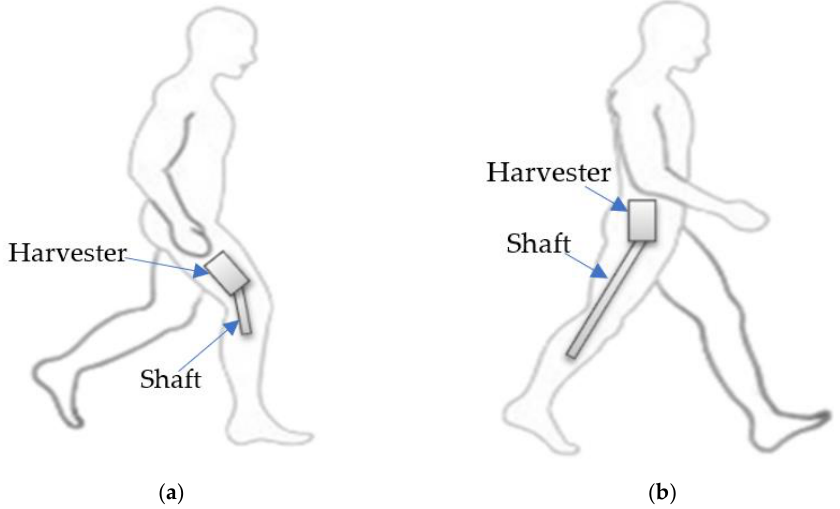
Figure 18. Knee biomechanical energy harvester placement. ( a ) attached to thigh ( b ) attached to hip. Case study 1: A male user with a 6-feet 2-inch height walked at 1.34 m/s pace for 30 min by wearing this energy harvester with a 250-mm shaft length. This case study is de- scribed in the following steps.